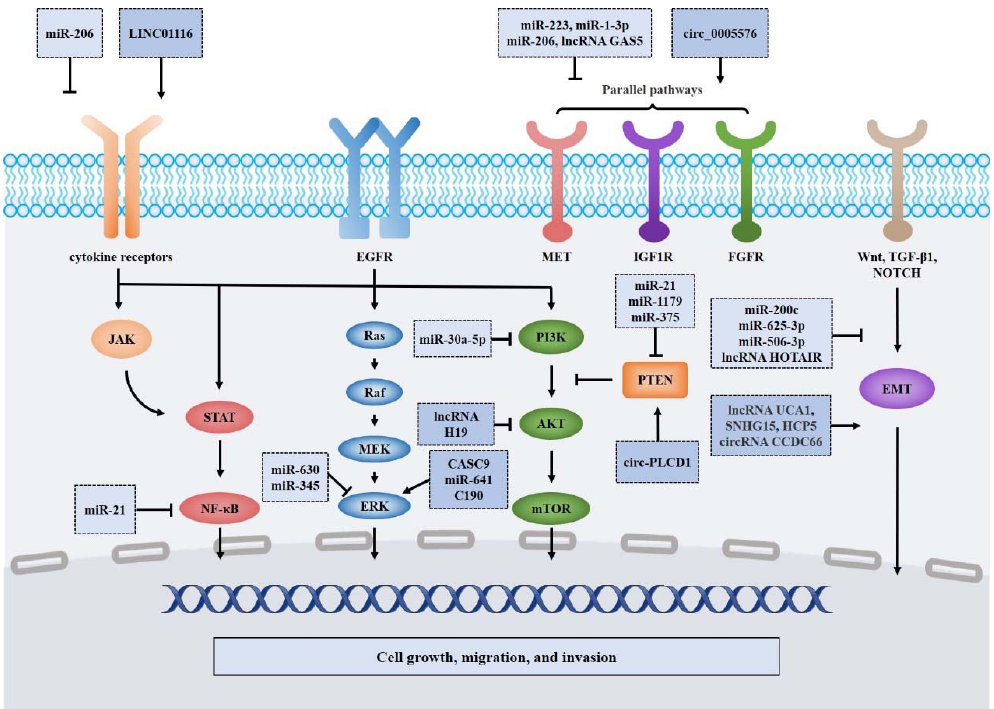
Figure 2. Mechanisms of EGFR-TKI resistance mediated by ncRNAs. Several critical ncRNAs can mediate the EGFR-TKI resistance through modulating the PI3K/AKT/mTOR, Ras/Raf/MEK/ERK, JAK/STAT, NF- κ B and EMT pathways. Abbreviations: EGFR, Epidermal growth factor receptor; EMT, epithelial-mesenchymal transition; IGF1R, Insulin-like growth factor 1 receptor; PTEN, phosphatase and tensin homologue; TGF- β , transforming growth factor- β